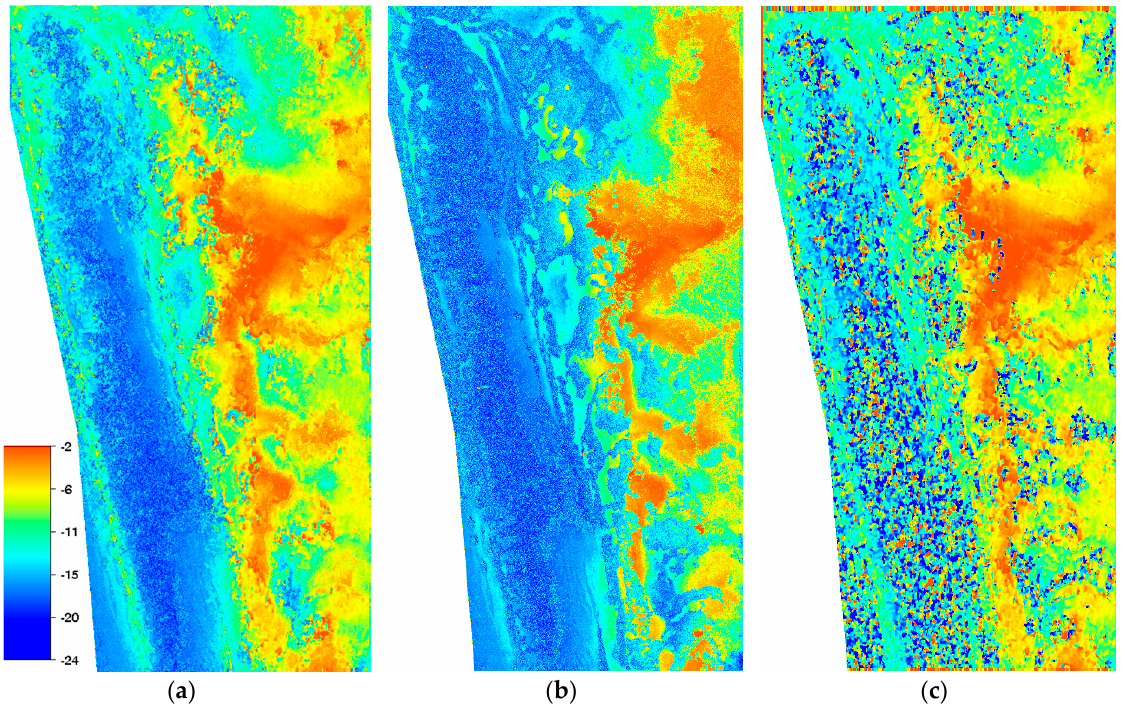
Figure 6. Three bathymetry images, with the same depth scale. ( a ) LiDAR depth, ( b ) depth estimates from SAMBUCA, and ( c ) depth estimates from stereo.